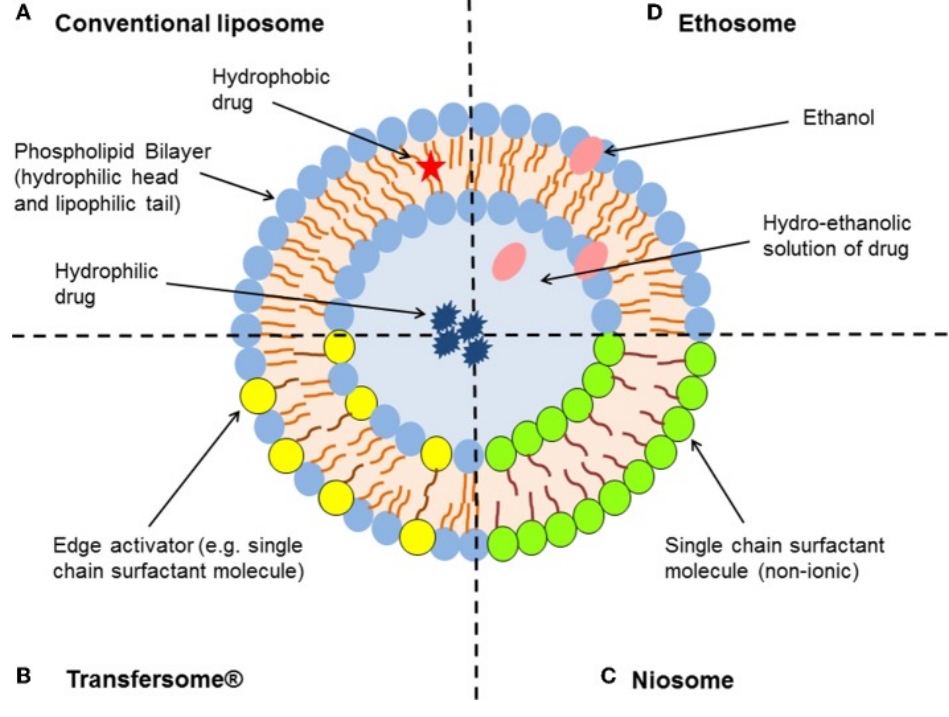
Figure 5. Examples of liposome-inspired vesicles [45]. Reprinted with permission from ref. [45]. Copyright 2015 Hua.